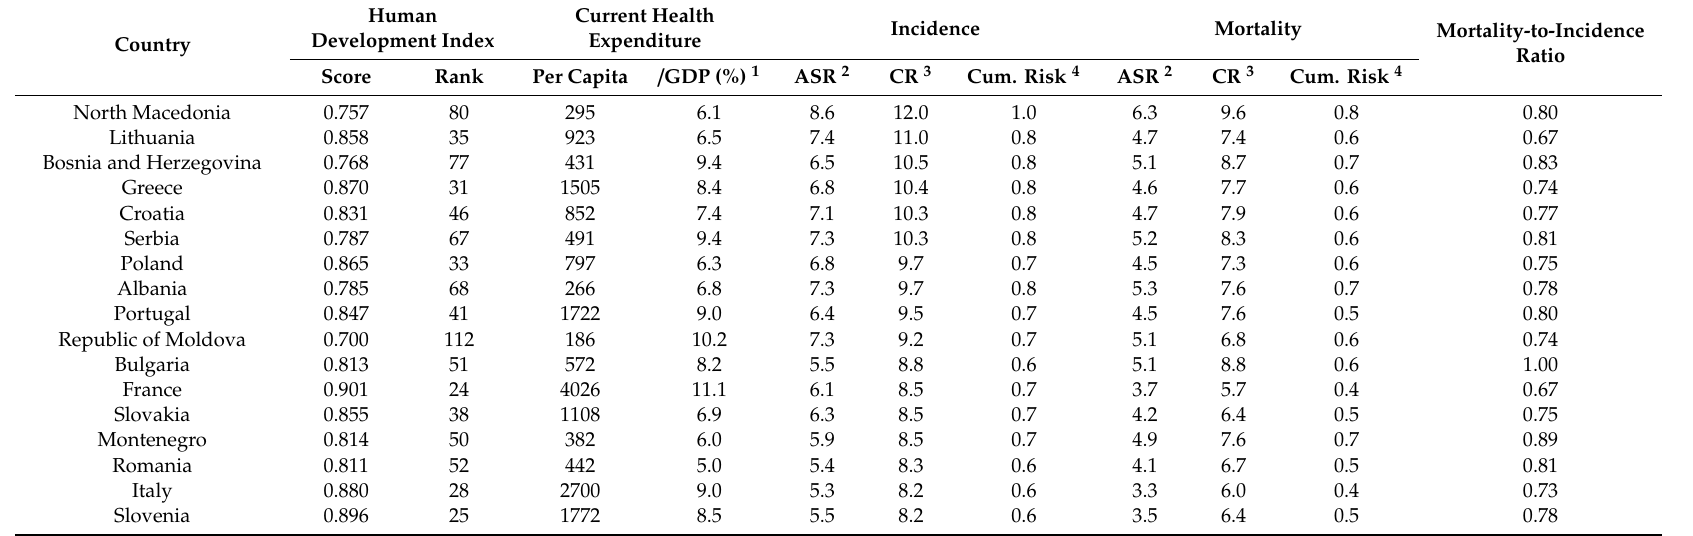
Table 2. Representative data for human development index, current health expenditure, cancer incidence, cancer mortality and mortality-to-incidence ratio in brain and nervous system cancers in selected countries according to ranking of incidence (N = 40). Human Current Health Incidence Mortality Development Index Expenditure Country